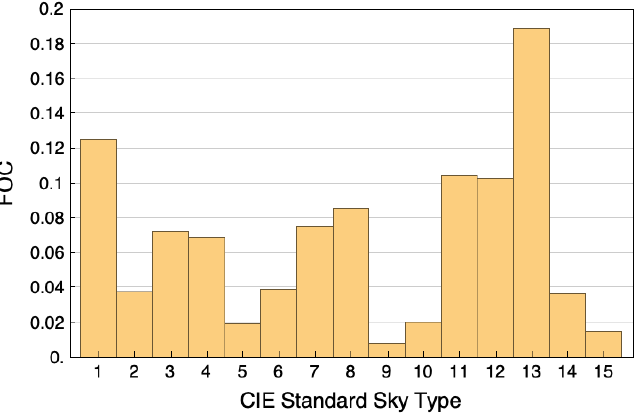
Figure 2. Frequency of Occurrence (FOC) of each CIE standard sky type in Burgos (Spain) from 14